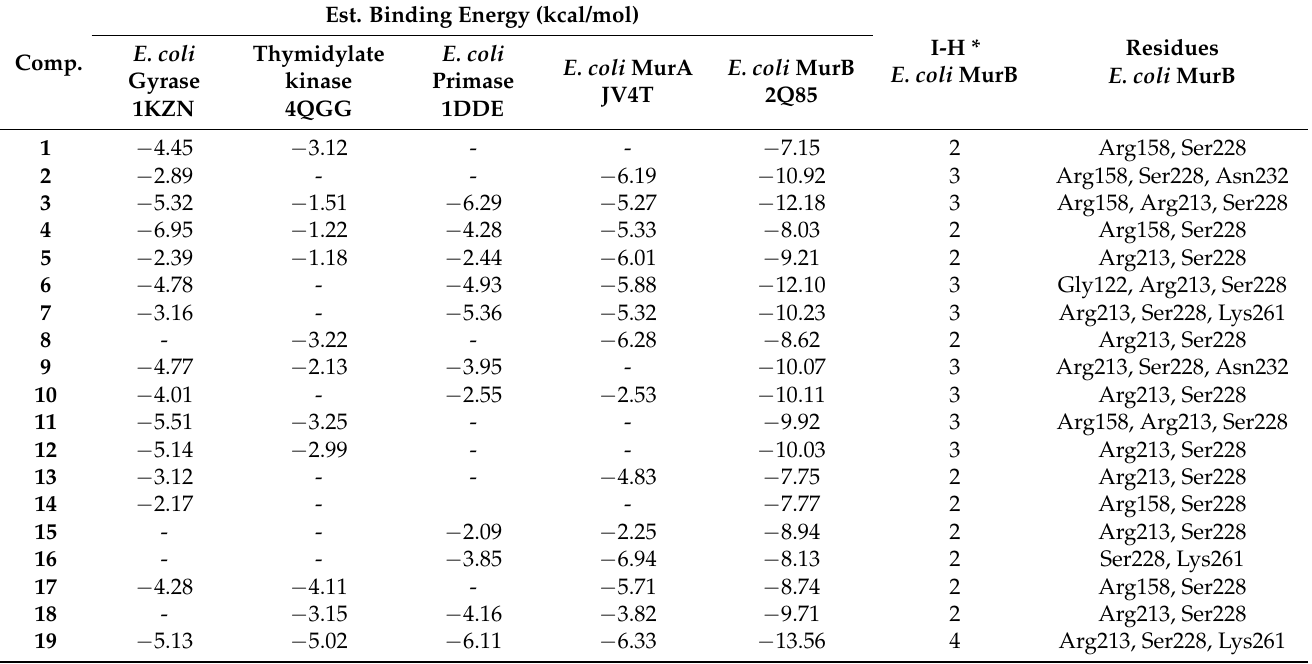
Table 6. Molecular docking results to antibacterial